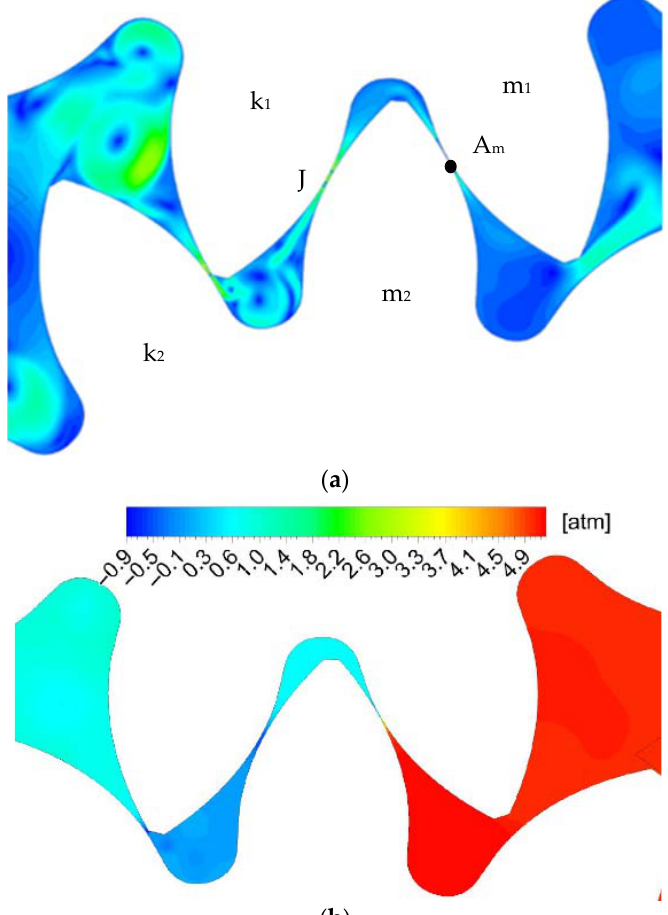
Figure 8. Position d: experimental result [18] picture 3.11; ( a ) velocity field (CFD); ( b ) pressure field (CFD).